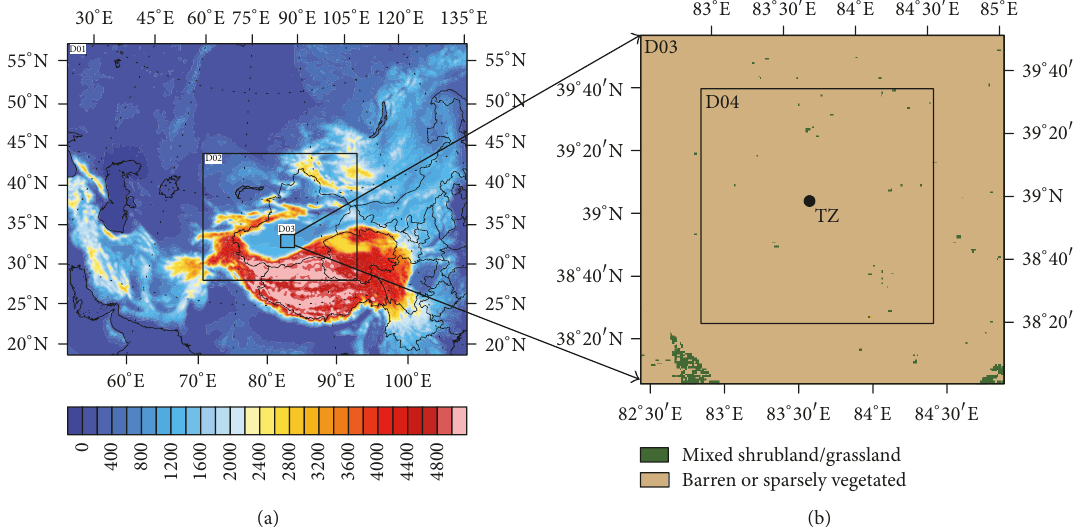
Figure 1: Simulation domains used in ARW model with terrain height (shading, units: m); (b) land use categories for domains D03 and D04.